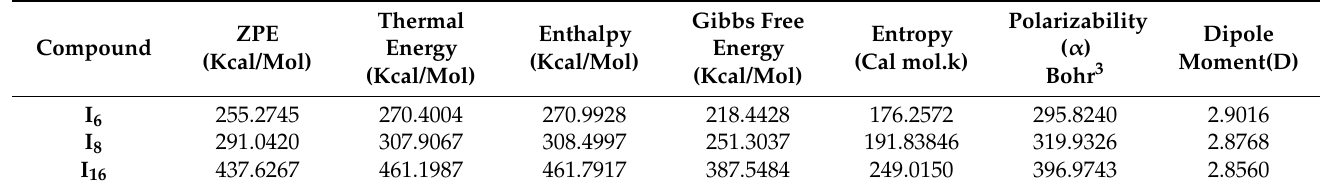
Table 2. Estimated thermal parameters, polarizability, and dipole moment for investigated series, I n .